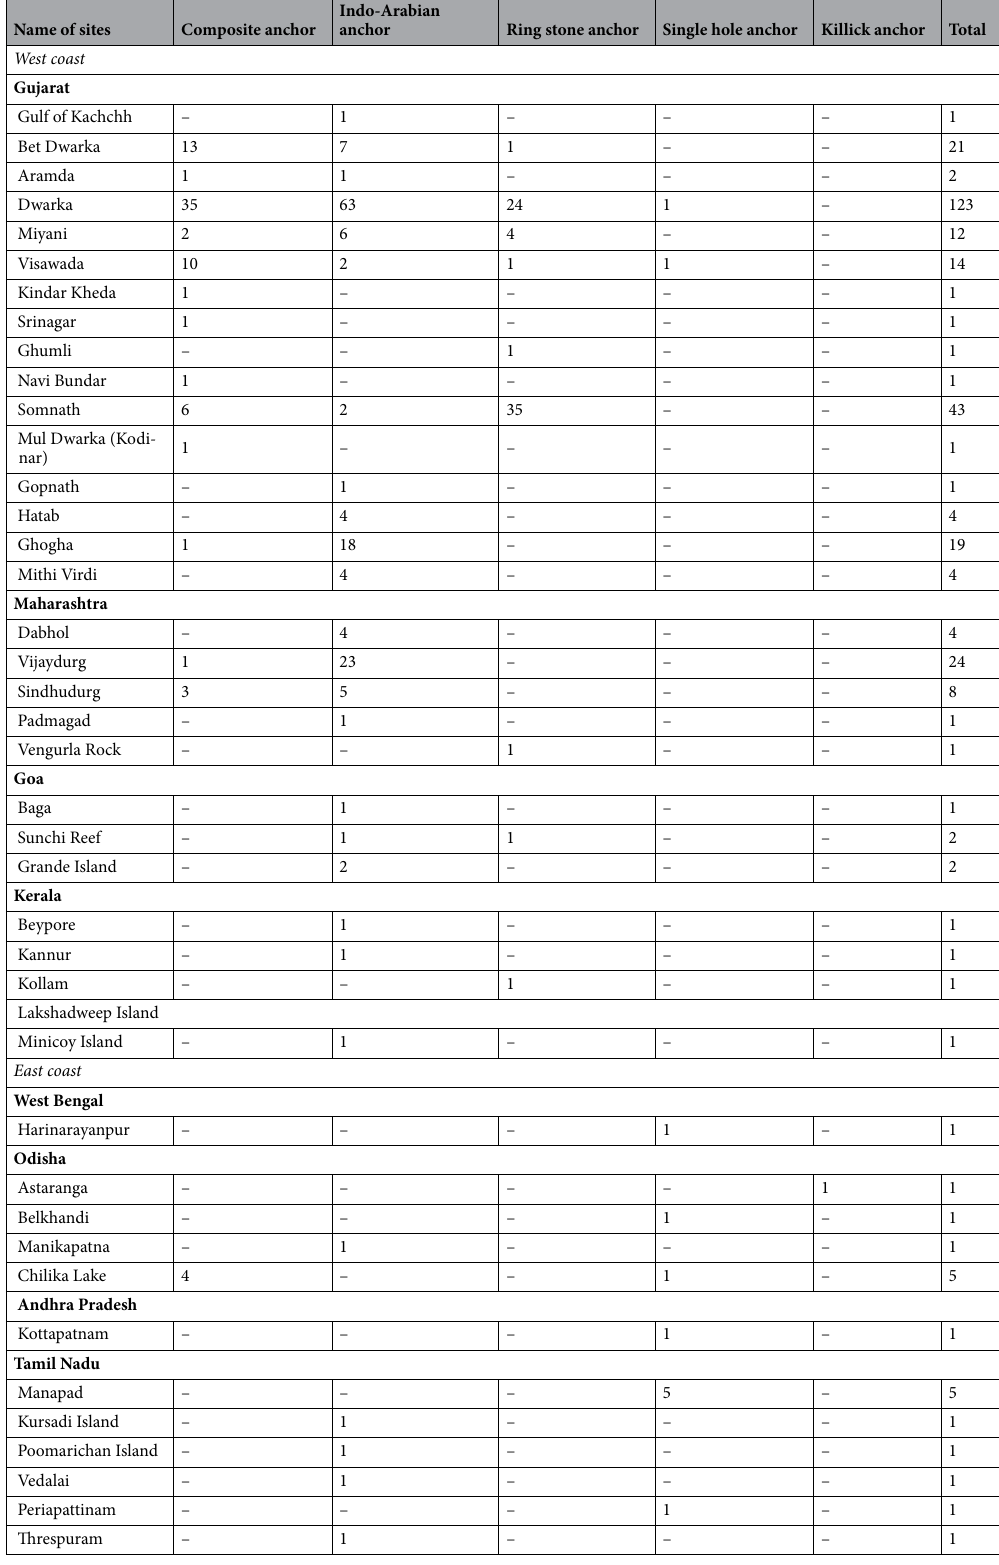
Table 1. Details of stone anchors found along the Indian